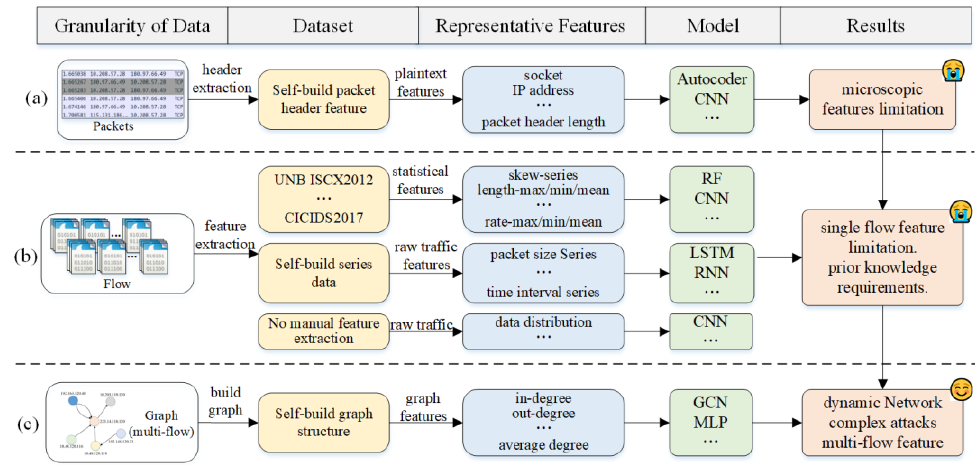
Figure 1. Three different attack identification methods.